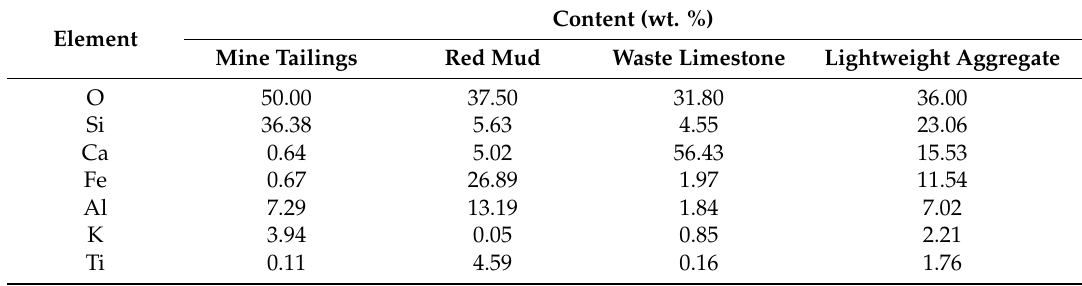
Table 1. Major compositions of the mine tailings, the red mud, the waste limestone, and the lightweight aggregate determined using X-ray fluorescence (XRF)